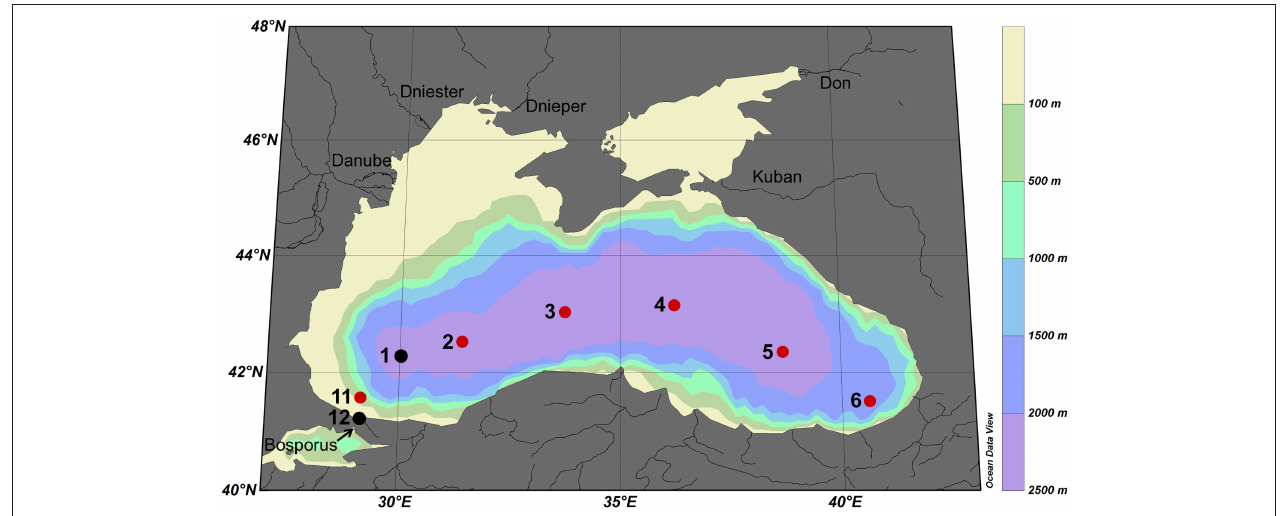
FIGURE 1 | Cruise track of research cruise 64PE373 on the RV Pelagia in July 2013. Red dots represent normal stations with typically 6 samples taken at 10, 25, 40, 55, 70, and 85m depth, black dots represent stations with only 1 or 2 samples taken. The five largest rivers are indicated.